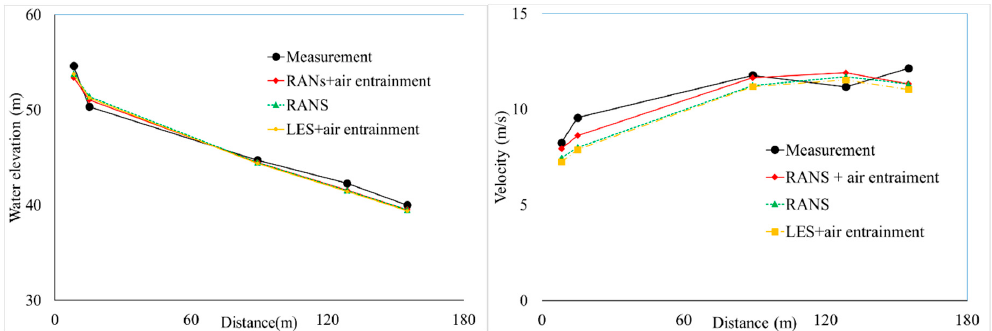
Figure 11. Water elevation and velocity in the complete case and Z up = 55.86 m.